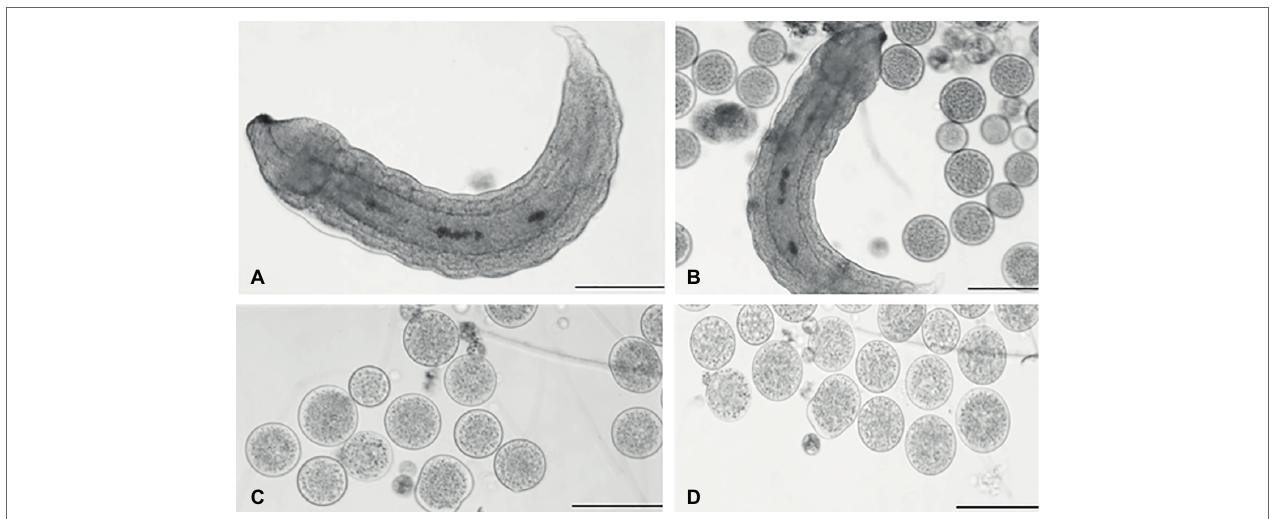
FIGURE 1 | Light microscopy of teratocytes. Aphidius ervi larva (A) . Teratocytes and Aphidius ervi larva observed in the host hemocoel 5 days after parasitization (B) . Teratocytes observed at 5 days after parasitization (C) . Teratocytes observed at 6 days after parasitization (D) . A stereo microscope Nikon SMZ800 was used for dissections, and images were observed at a light microscopy using Nikon Eclipse 80i at 10× magnification. The images were recorded by Nikon Digital Sight DS-U1 camera and ImageJ software. Bars in (A) – (D) , 100